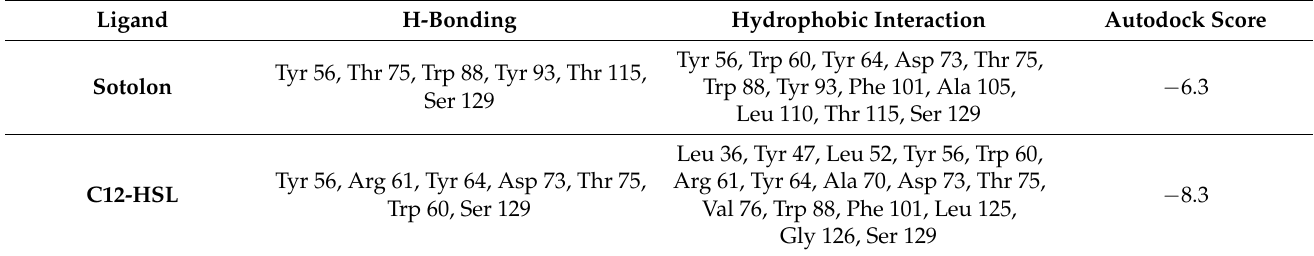
Table 1. The binding mode of each ligand with the different residues inside the active site of lasR.